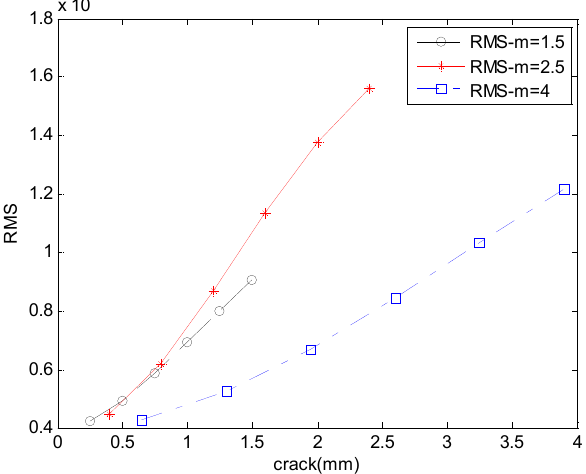
Figure 22. RMS for the vibration response under the changing modulus.